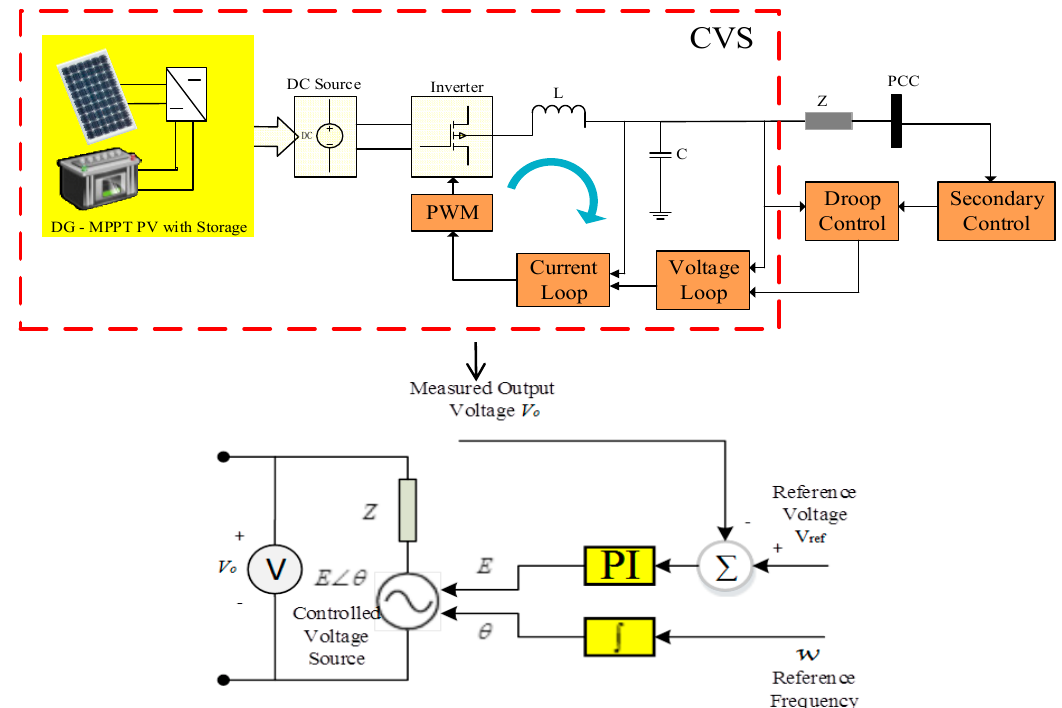
Figure 1. Diagram of the inverter with droop loop and secondary loop.